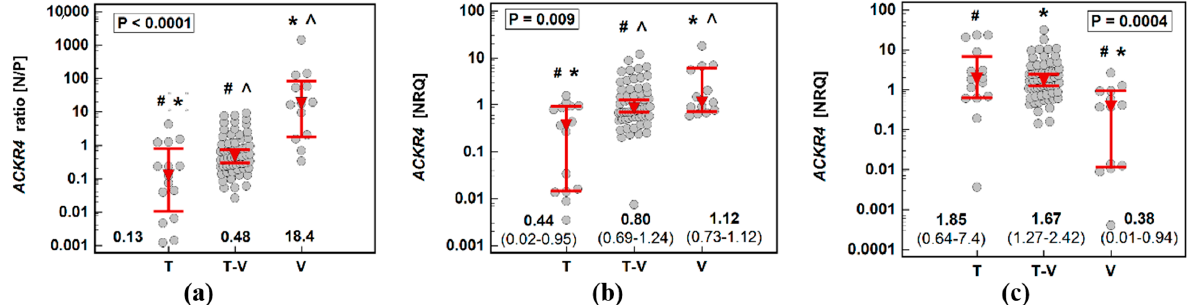
Figure 2. Impact of adenoma histological type on ACKR4 expression: ( a ) normal–to-polyp expression ratio (N/P); ( b ) in nor- mal tissue; ( c ) in adenomas. Data presented as dot-plots with medians with 95% confidence interval (figures below the dot-plots and red triangles with whiskers) and analyzed using a Kruskal–Wallis H test with a Conover post hoc test. Groups differing significantly in a post hoc analysis are indicated by the same type of symbol: *, #, or ˆ. T, tubular adenomas; T-V, tubulovillous adenomas; V, villous adenomas; NRQ, normalized relative quantity.